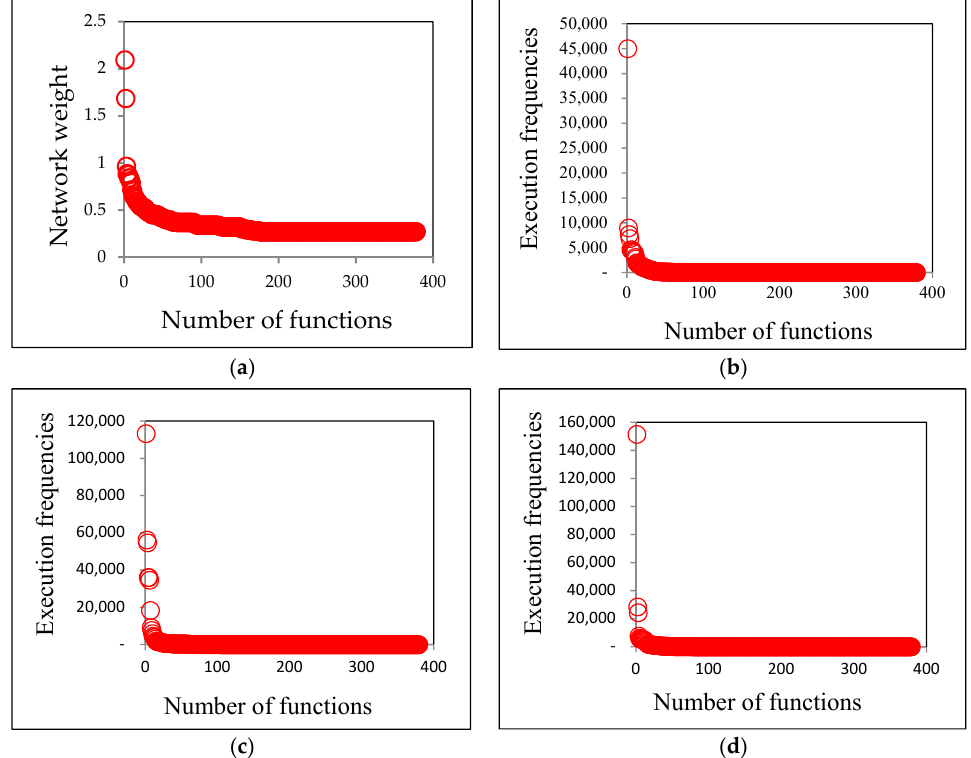
Figure 4. The function ranking distribution of integrated network weight and three execution frequencies; ( a ) Ranking distribution of integrated network weight; ( b ) Ranking distribution of the execution frequency with the highest correlation (H); ( c ) Ranking distribution of the execution frequency with the medium correlation (M); ( d ) Ranking distribution of the execution frequency with the lowest correlation (L).